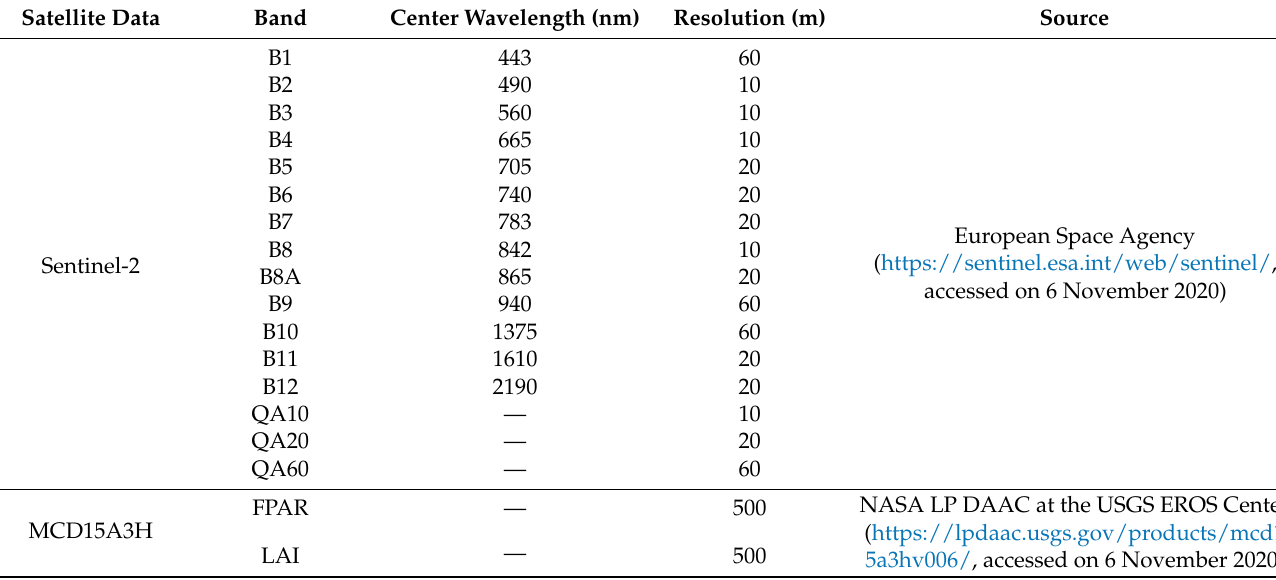
Table 1. Satellite data and